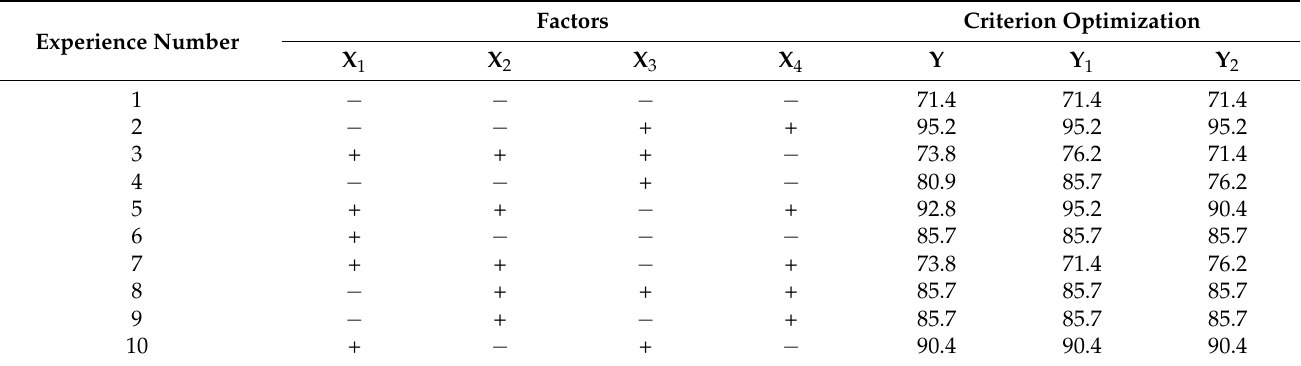
Table 3. Planning matrix and screening experiment